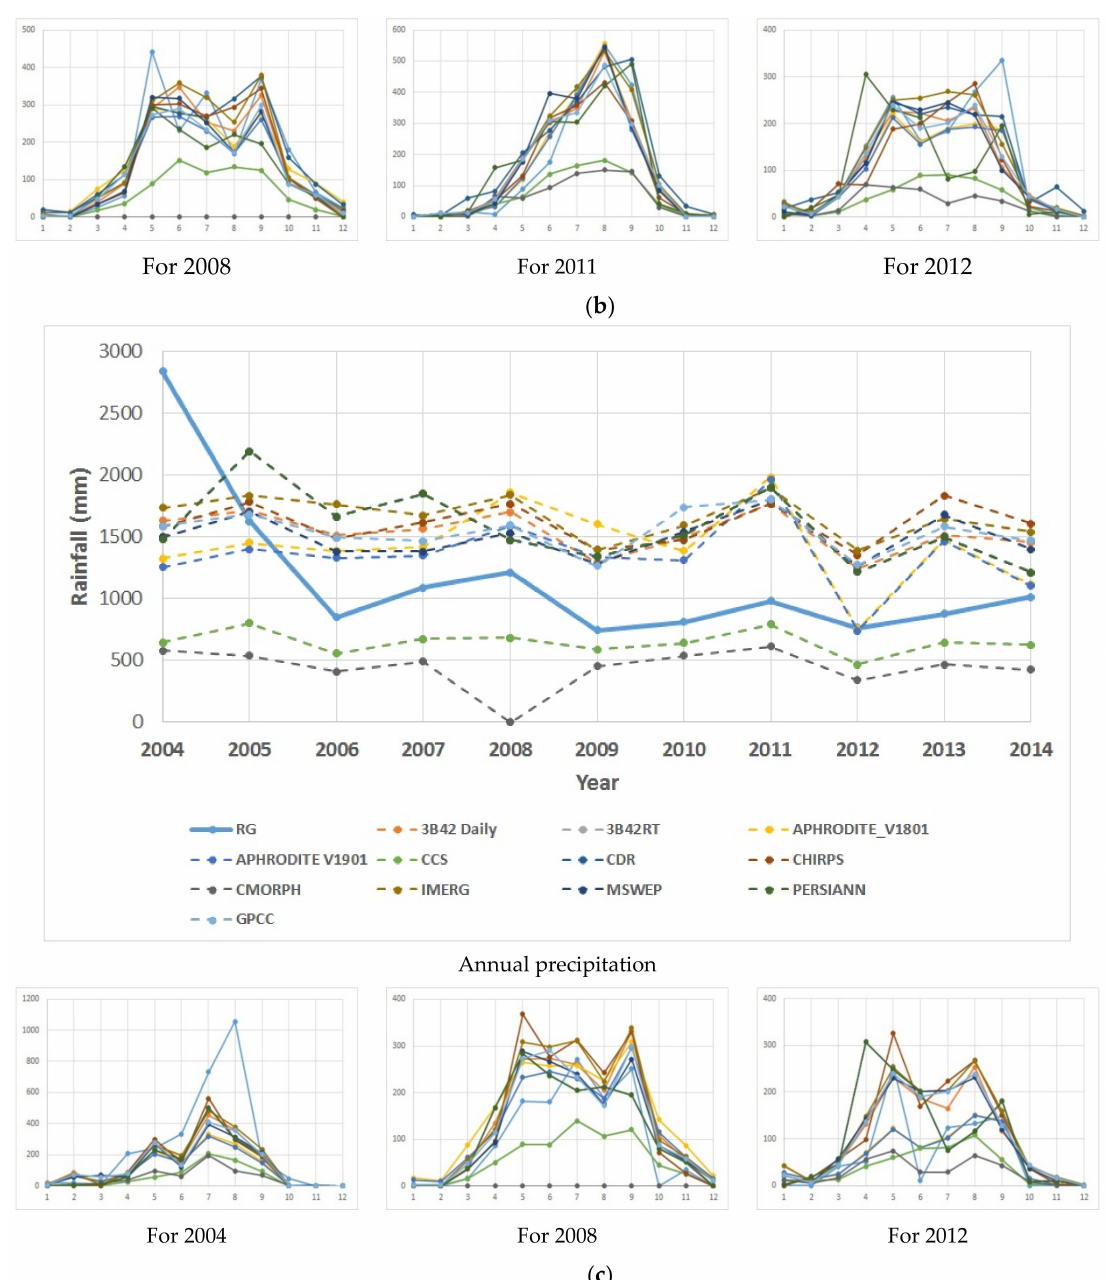
Figure 4. Annual and monthly rainfall of different precipitation products. ( a ) For station 640112; ( b ) For station 640122; ( c ) For station